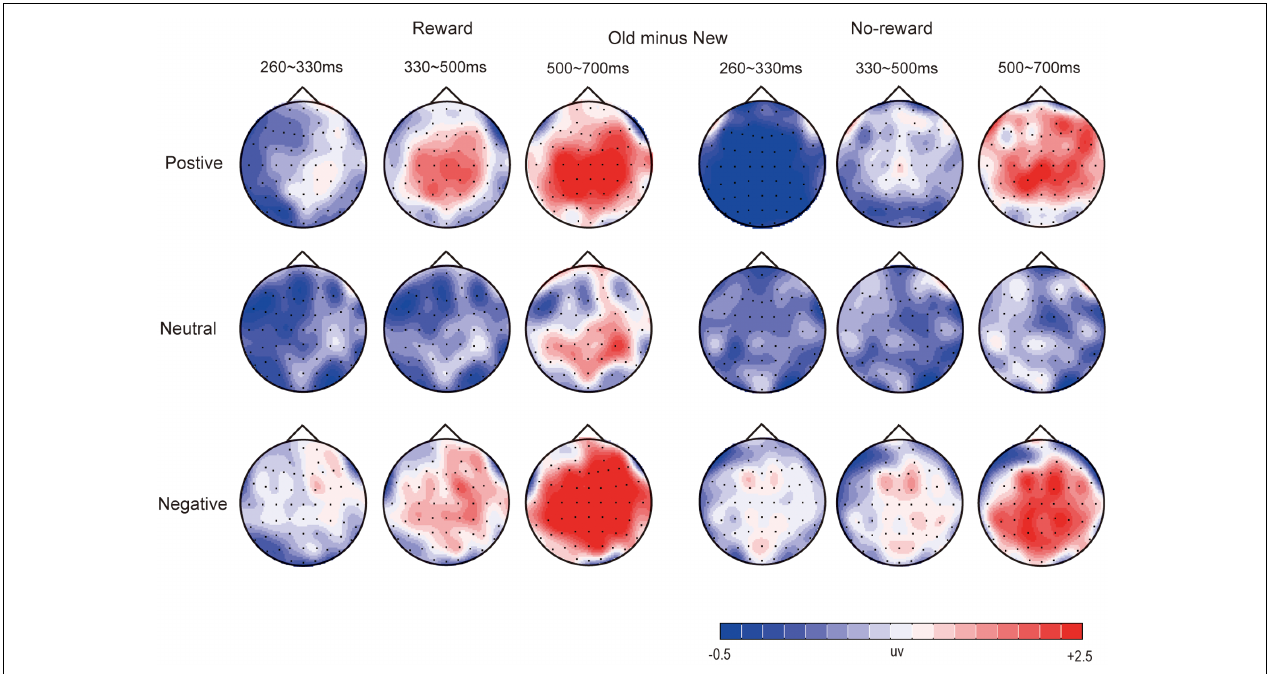
FIGURE 4 | The topographic map of ERP about old/new effects in rewarded and no-rewarded old items under positive, neutral, and negative conditions.